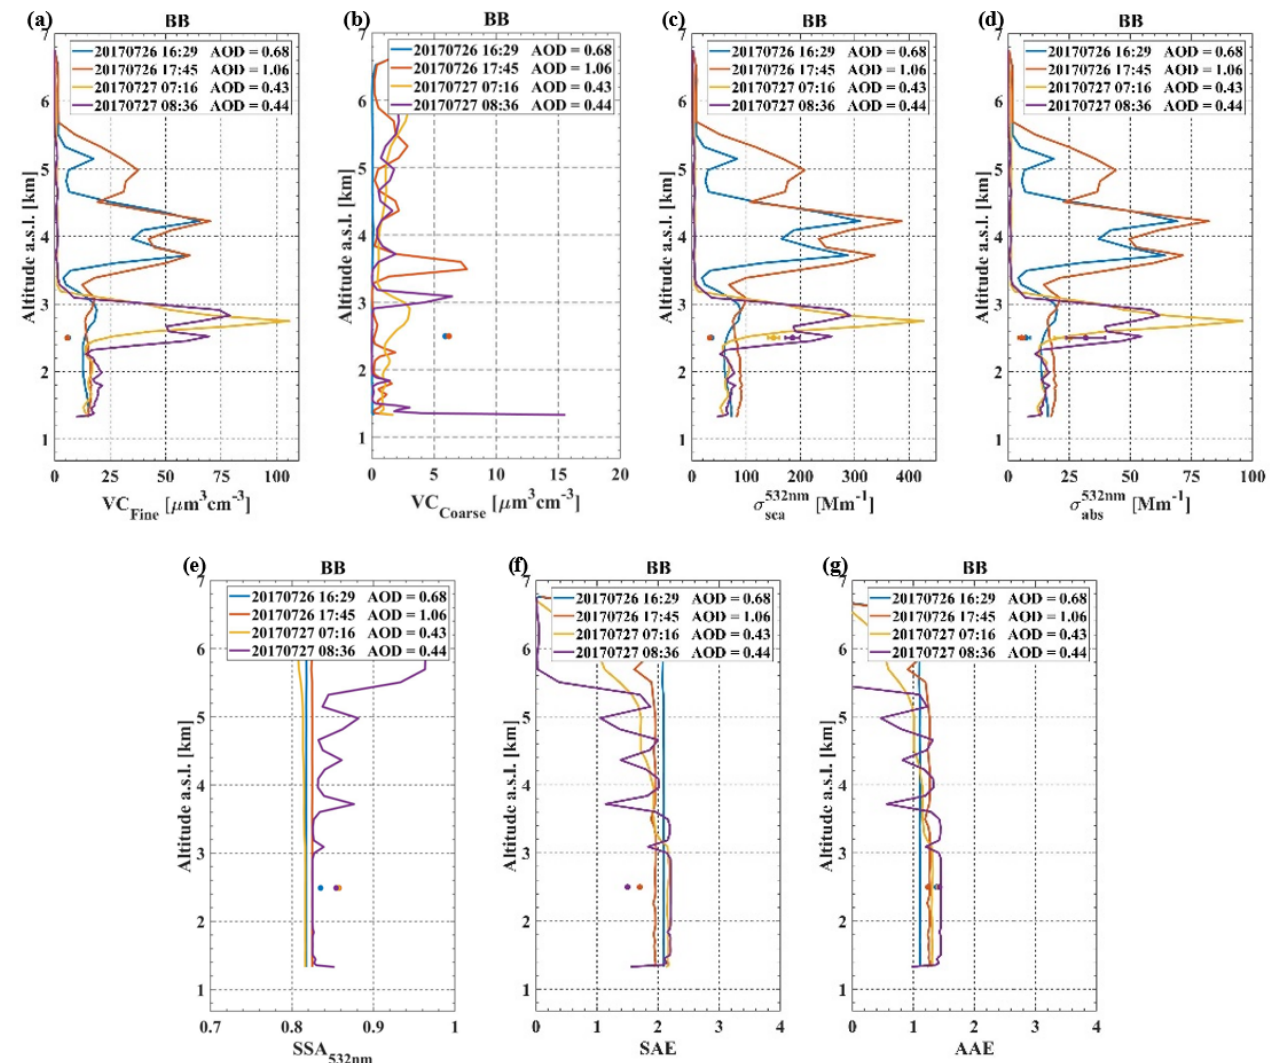
Figure 10. Volume concentration for (a) fine and (b) coarse modes, (c) scattering ( σ sca ) and (d) absorption ( σ abs ) coefficients, (e) single scattering albedo (SSA) at 532nm, (f) scattering Ångström exponent (SAE), and (g) absorption Ångström exponent (AAE) retrieved by GRASP (line) and the SNS measurements (point) during biomass burning event on 26 and 27 July 2017. The AOD shown is at